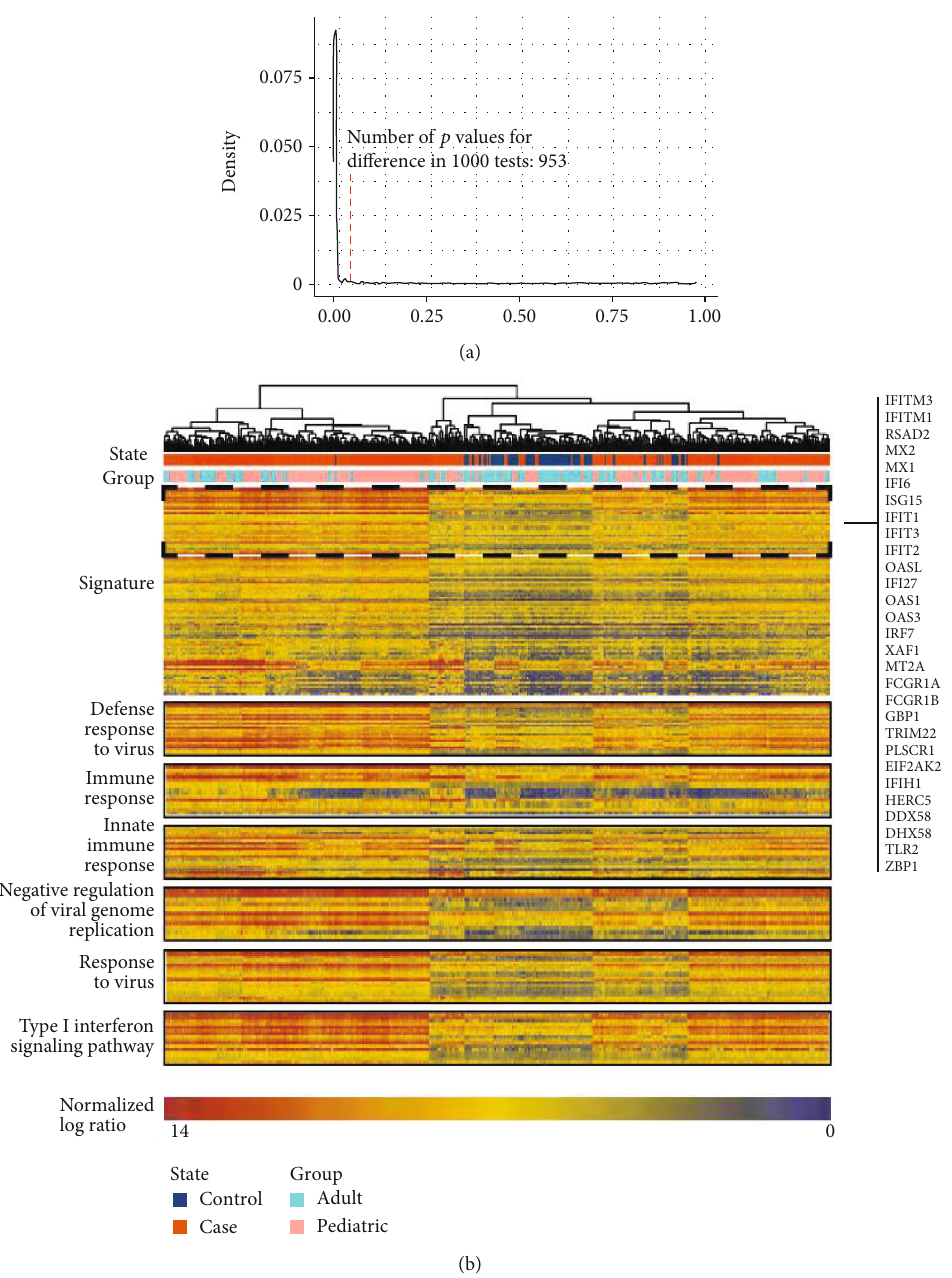
Figure 1: Analysis of signature in discovery set. (a) Correlation score permutation analysis. Null distribution generated by randomly permuting the expression pro fi le 1000 times and identifying the number of p values for di ff erences that were also signi fi cant ( p < 0 : 05 ). The red line indicates the number of p values for signi fi cant di ff erences in 1000 tests. (b) Heat map of signature in discovery set. 405 samples composing the SLE cohort were clustered using 92 genes. The column annotations across the top provide the distribution of the two queues (Group, State), and rows are fi xed by biologically relevant gene sets. The heat map shows that samples from one data site are not clustered together, indicating limited batch e ff (Figure S1), and the model is further corrected by determining subtype characteristics. We calculated the expression value of the subtype signature genes and the distance from the samples to the expression value and reclassi fi ed the subtypes according to the distance. After several iterations of correction, it was found that the model converged when only a few samples were changed.